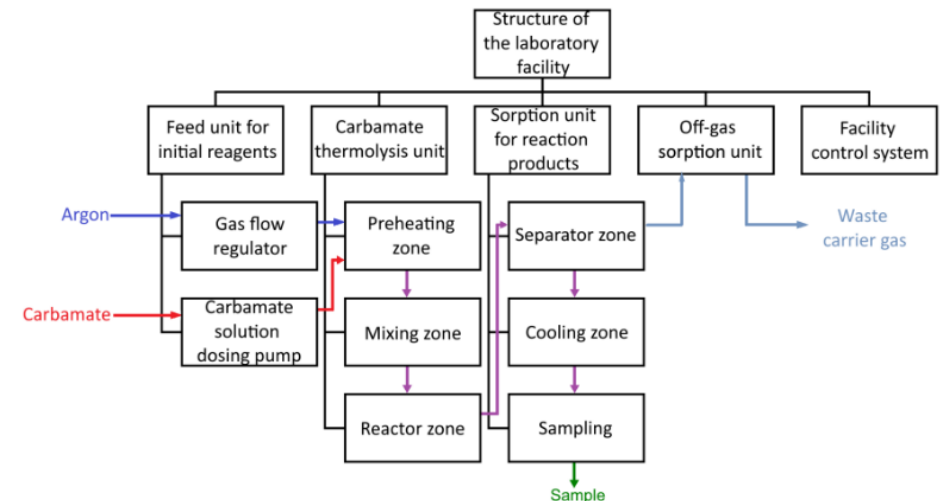
Figure 2. Block diagram of an experimental facility for carbamate thermolysis.